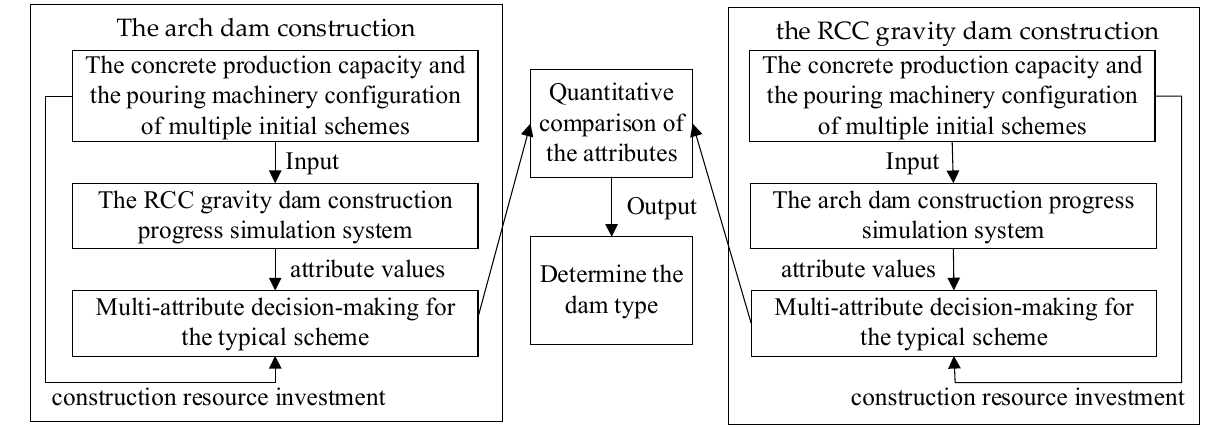
Figure 8. The comparison method process of dam types. Table 4. Construction resource investment of the arch dam construction schemes.